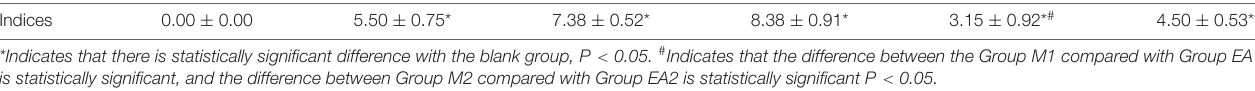
Frontiers in Physiology |